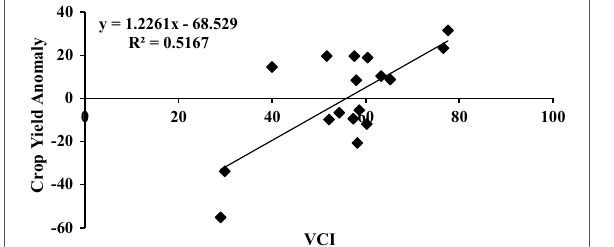
Table 5 Metrological drought during 2009 and